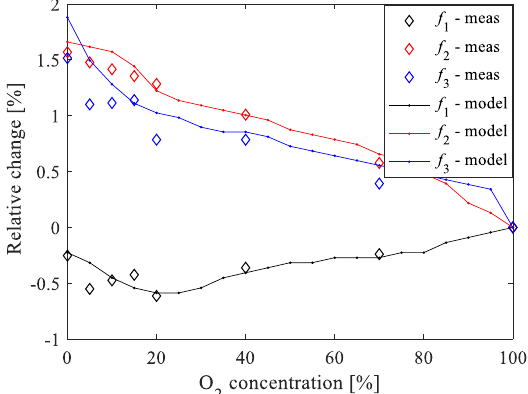
Figure 16. Comparison between measurements (symbols) and ANN simulations (lines) of the relative changes of the resonant frequencies versus the O 2 concentration. The used reference value of the O 2 concentration is 100%.